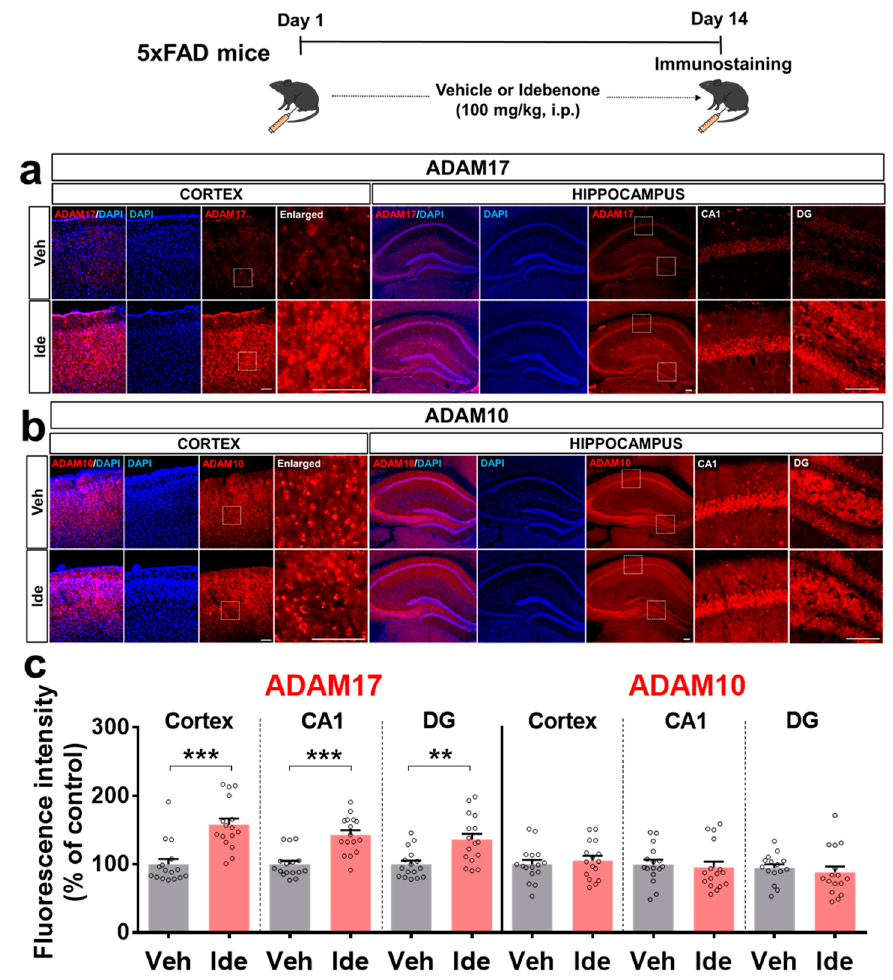
Figure 5. Idebenone significantly increases ADAM17 levels in a mouse model of AD. ( a , b ) Repre- sentative images of cortical and hippocampal ADAM17 and ADAM10 immunofluorescent staining. Idebenone or vehicle was administered daily to 3-month-old mice for 14 consecutive days as shown at the top of the figure. Immunostaining of brain sections was then performed with anti-ADAM17 and anti-ADAM10. ( c ) Quantification of the results (n = 15–16 brain slices from 4 mice/group). ** p < 0.01 and *** p < 0.001 vs. vehicle-treated control. Scale bar = 100 µm for cortex and 200 µm for hippocampus.